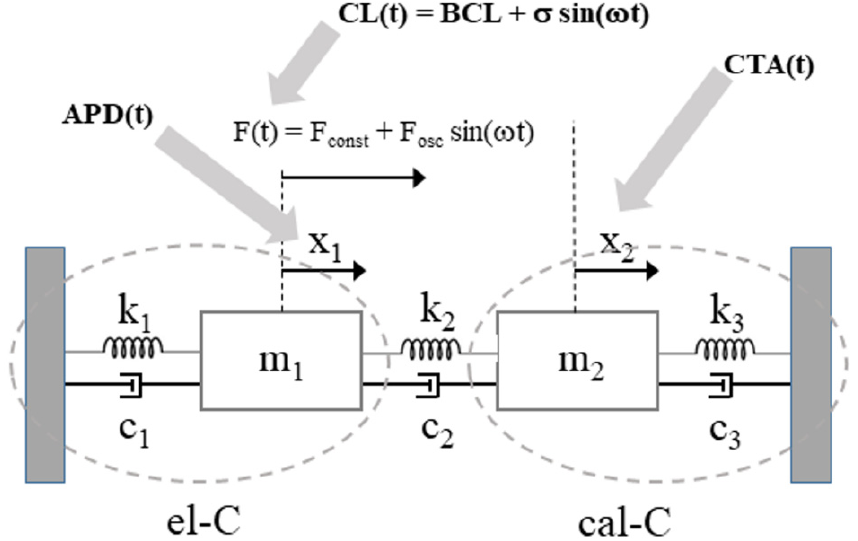
Figure 6. Schematics of the mechanical model. The mechanical mass-spring model is made by two masses (m i ) connected with each other and with fixed walls through springs (stiffness k) and dampers (damping c). Corresponding EC coupling entities indicated by arrows. The system k 1 -c 1 -m 1 represents the el–C compartment, k 3 -c 3 -m 2 represents the cal–C compartment, m 1 is externally driven by a sinusoidal force F following Equation (7) and corresponding to the oscillating CL. Horizontal displacement of the two masses (x 1 and x 2 ) correspond to APD and CTA, respectively. The two oscillators are coupled via spring k 2 and damper c 2 .